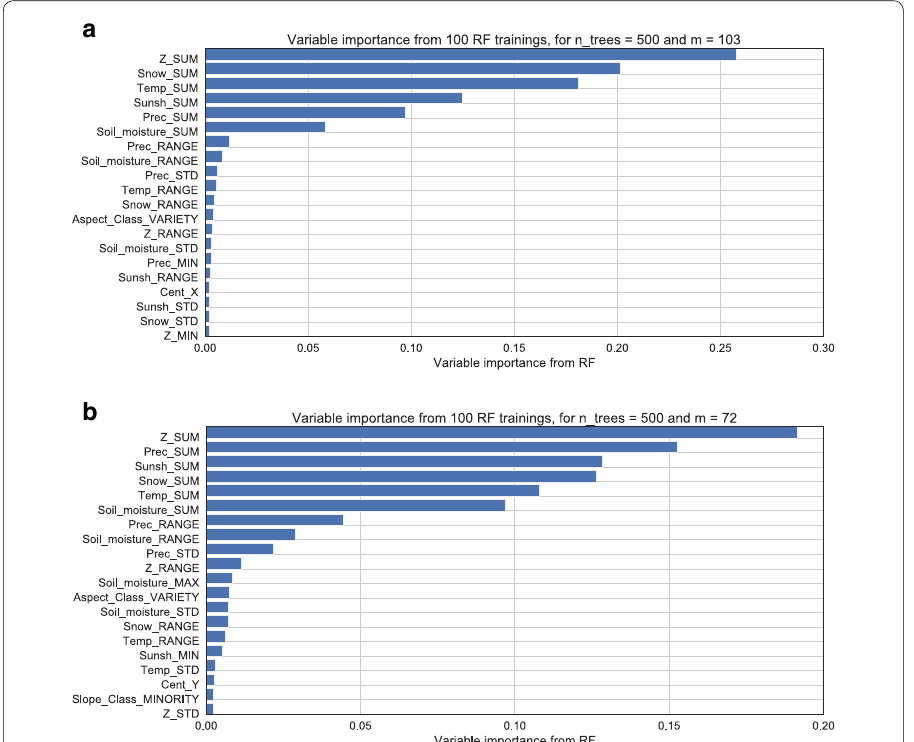
Fig. 20 Variable Importances (VI) (2). See definition of each feature (e.g., Temp_SUM ) in Appendix 2: Table 10. a For the RF model trained for the estimation of the thermal diffusivity, considering soil texture; b for the RF model trained for the estimation of the thermal diffusivity, discarding soil